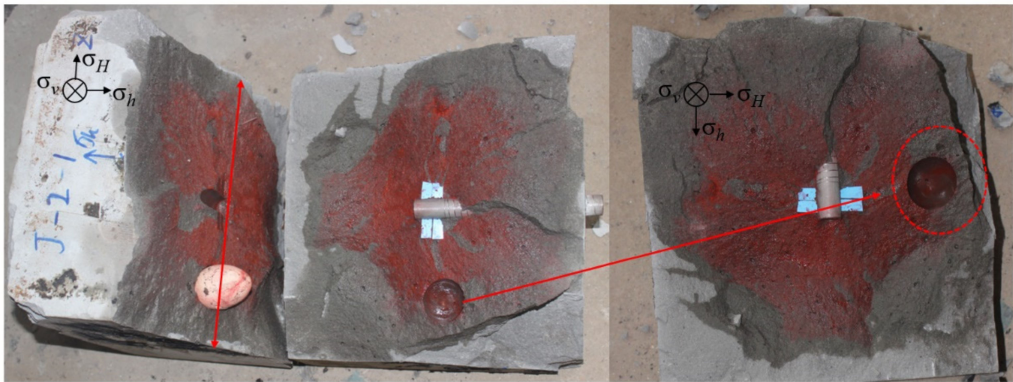
Figure 8. Hydraulic fracture geometry of sample